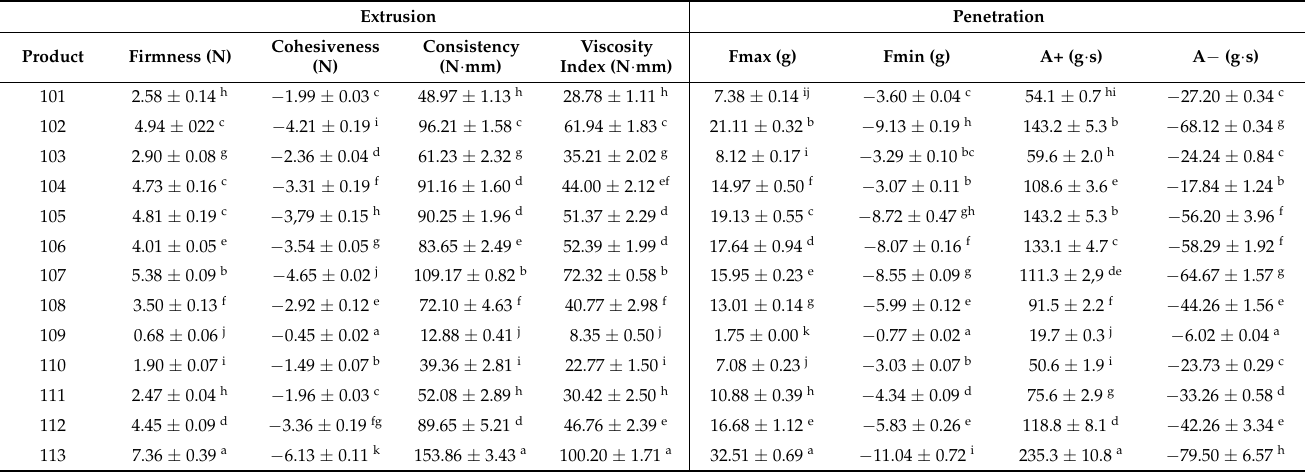
Table 10. Textural data (means ± SD) from the extrusion and penetration tests for the 13 cosmetic